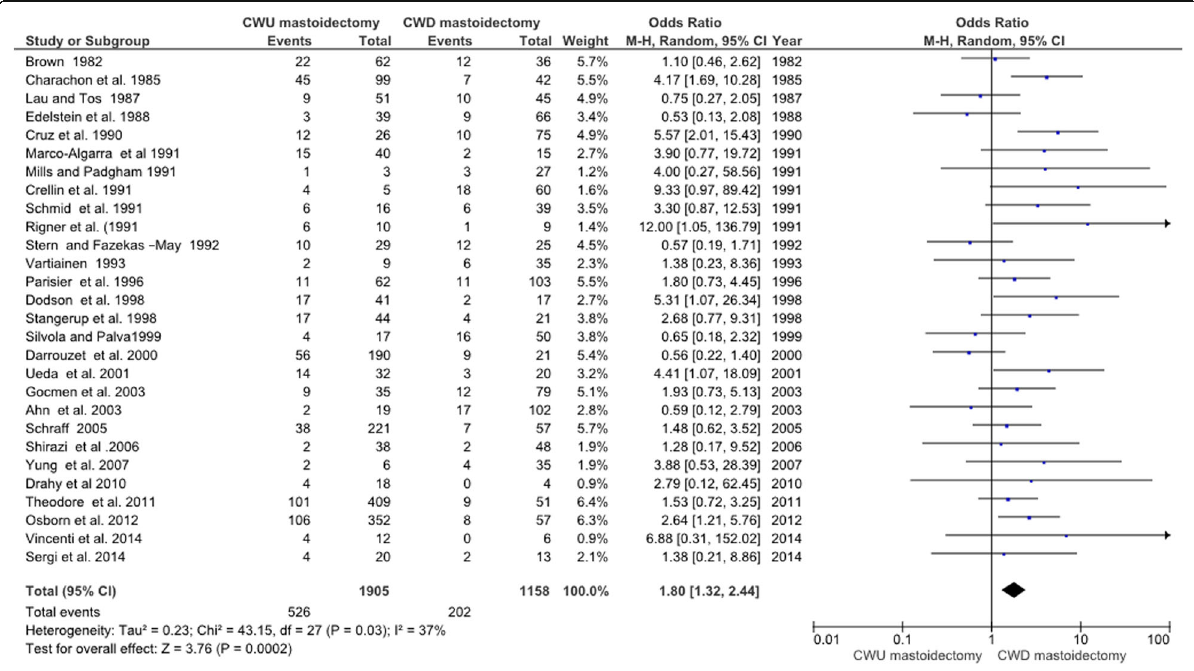
Fig. 2 Forest plot of all data (random effects model)